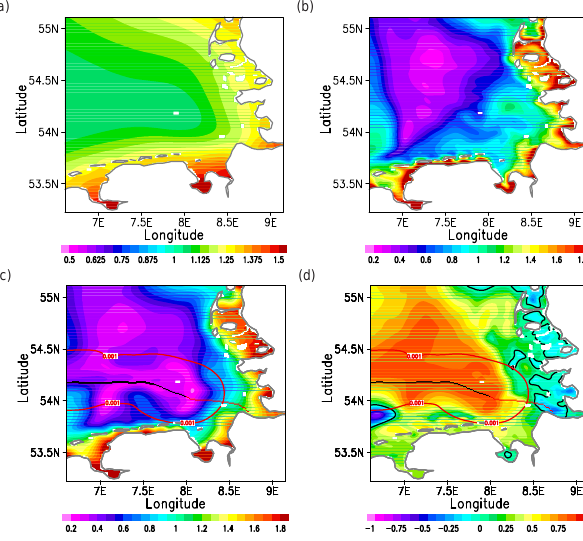
Fig. 15. Error range of OSTIA SST for March 2009 (a) . (b) and (c) show temporal mean RMSE for the March 2009 using OSTIA SST and SST from the Free Run and DA Run analysis fields, respec- tively. (d) shows the Skill of DA Run, which corresponds to (b) and (c) . The red line in c) and d) indicates the area around the ferry track in which the value of the Gaussian decay used in the locali- sation lies above 10 − 3 . Beyond this line the influence of the data assimilation can be 51